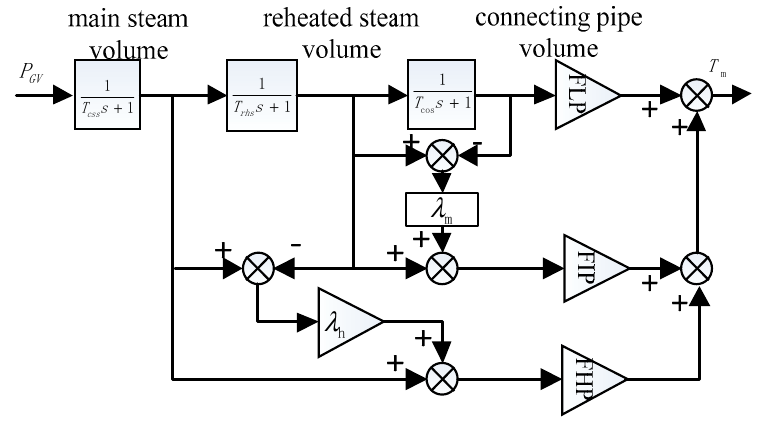
Figure 2. Principle block diagram of turbine prime mover transfer function [9].